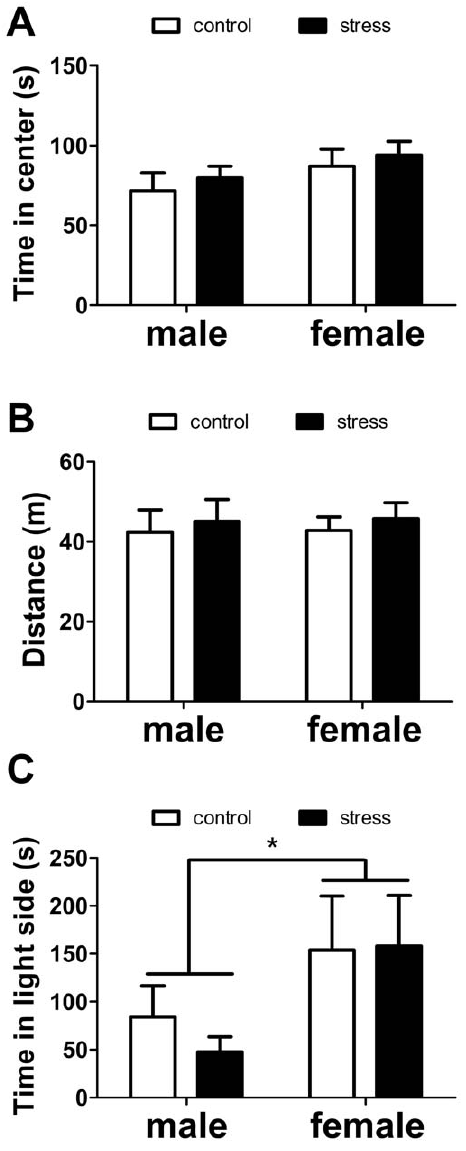
Figure 7. Effects of social defeat in the habituation-dishabit- uation test. Social defeat reduced time spent investigating a glass slide with a water droplet (trials 1–3) in both males (A) and females (B). In males defeat reduced, but did not eliminate investigation of novel male odors (trial 4 and 7). Females exposed to defeat did not show a significant increase in investigation time of novel female odors (trials 4 and 7). { , {{ Mann-Whitney effect of stress p , 0.05 and p , 0.01 respectively. *, ** Wilcoxon test versus previous trial (trial 3 vs. 4 or 6 vs. 7) p , 0.05, p , 0.01 respectively. All data are mean 6 s.e.